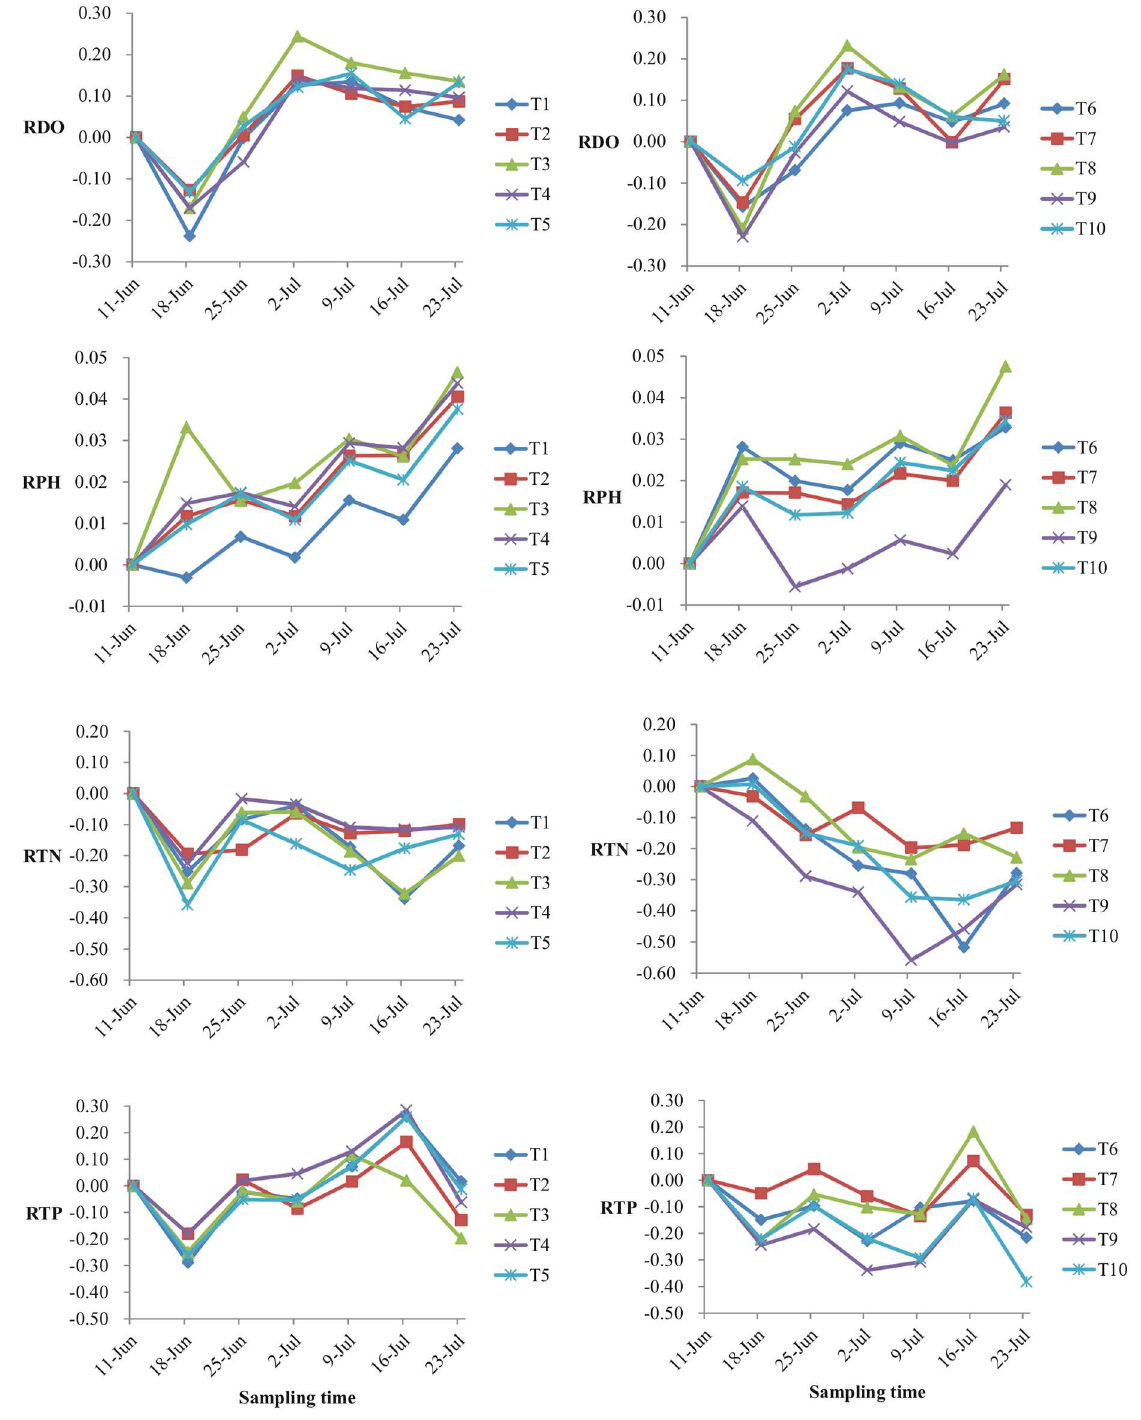
Fig 2. P/A values for DO (RDO), pH (RPH), TN (RTN) and TP (RTP) for each treatment.